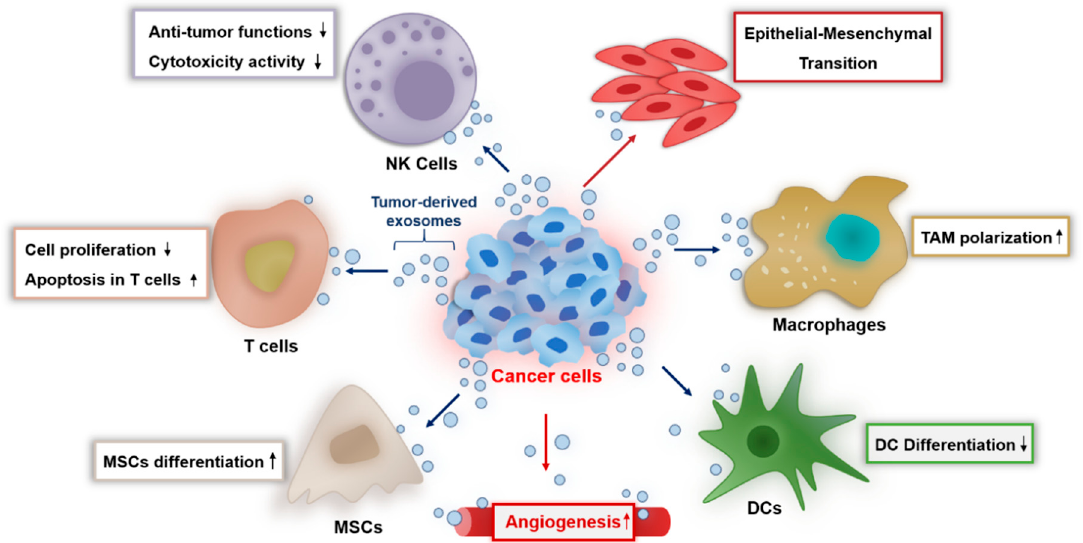
Figure 2. Overview of the role of tumor-derived exosomes in the tumor microenvironment. Exosomes secreted by cancer cells can induce epithelial-mesenchymal transition in other cancer cells and promote the differentiation of mesenchymal stem cells (MSCs). Cancer cells can promote angiogenesis and polarize macrophages to tumor-associated macrophages (TAM), a tumor-supporting phenotype. Tumor-derived exosomes are able to suppress the antitumor response of immune cells such as natural-killer (NK) cells, T cells, and dsendritic cells